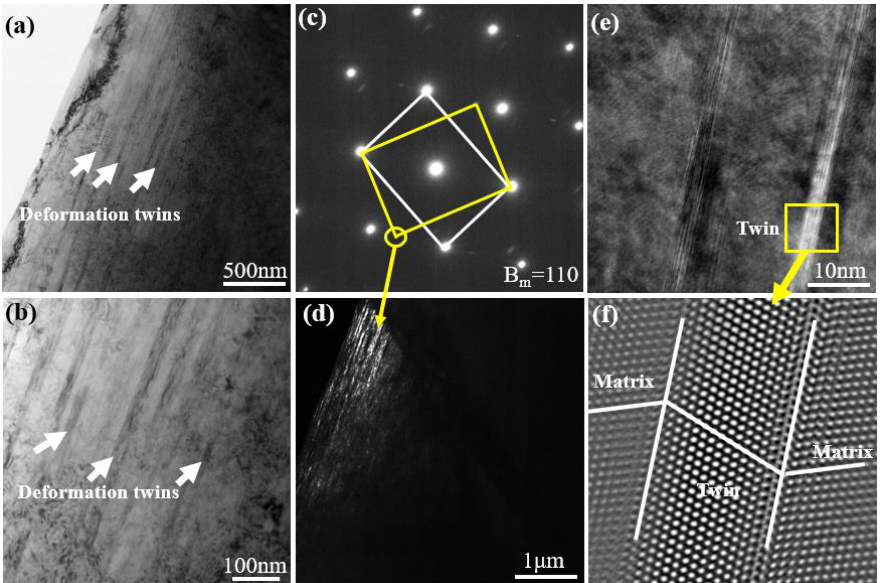
Figure 6. Deformed microstructures after tensile testing at 760 °C: ( a ) bright field image with a lower magnification; ( b ) bright field image with a higher magnification; ( c ) a SAED pattern; ( d ) dark field image corresponding to ( c ); ( e ) HRTEM image showing a twin lamella; ( f ) inverse Fourier transform image corresponding to ( e ).